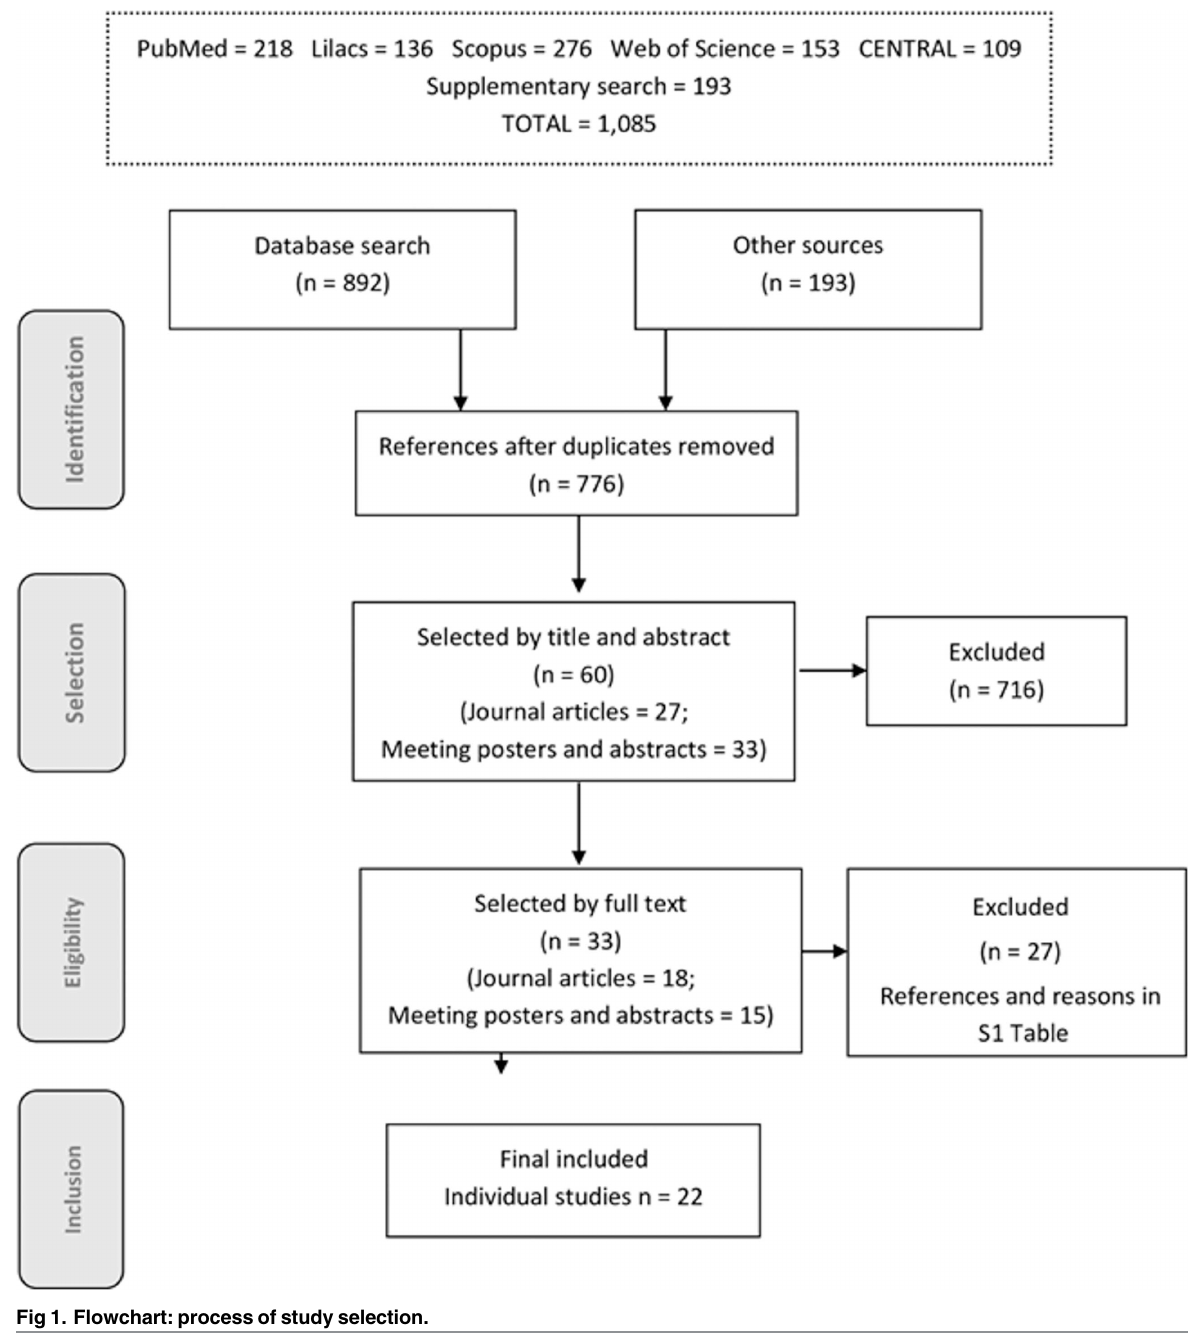
Fig 1. Flowchart: process of study